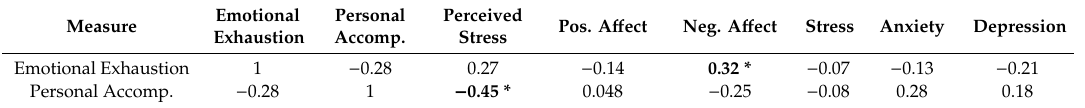
Table 3. Correlation matrix between study outcomes.